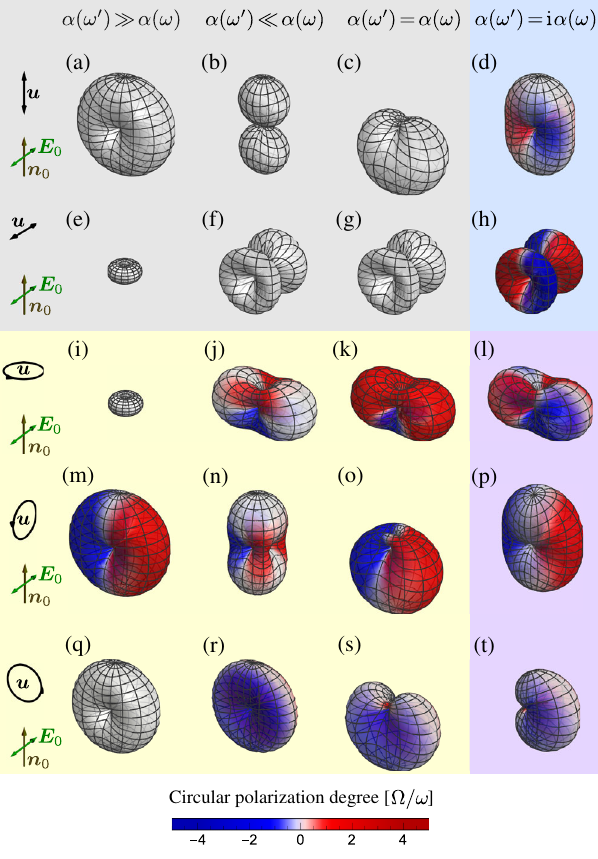
FIG. 5. The anti-Stokes light scattering pattern with the degree of circular polarization marked by red and blue colors. Light is incident from the bottom and linearly polarized, see yellow and green arrows on the left, respectively. Rows correspond to different trembling directions indicated by black arrows on the left. Columns correspond to different relations between particle polarizabilities at the frequencies of incident and scattered light, α ð ω Þ and α ð ω 0 Þ , indicated in the top. The colored areas represent different origins of the optomechanical spin-Hall effect: phase difference between the polarizabilities α ð ω Þ and α ð ω 0 Þ (blue color), the phase difference between components of the displacement vector u (yellow color), or their combined action (purple